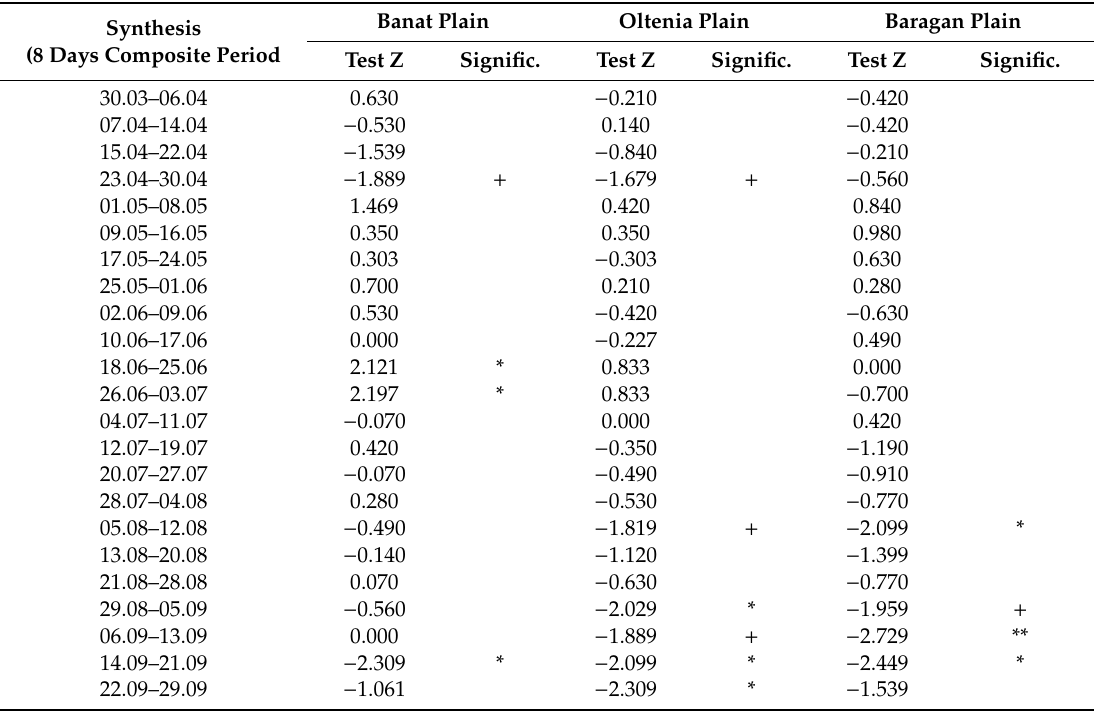
Table 6. Soil Moisture Anomaly trend according to the Mann-Kendall test